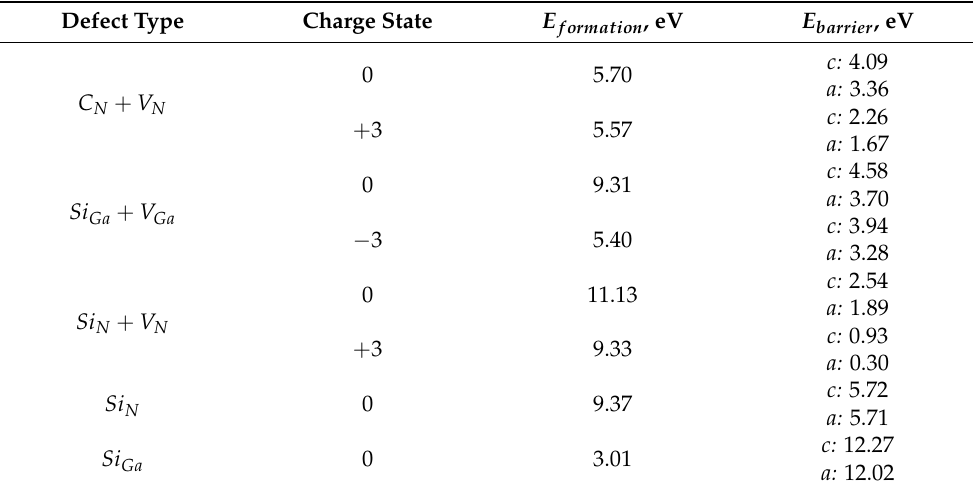
Table 3. Heights of the migration energy barriers of selected substitutional dopants in wz-GaN crystal. N-rich growth conditions are